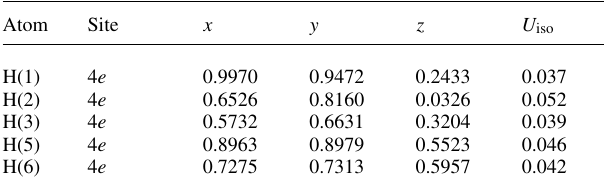
Table 2. Atomic coordinates and displacement parameters (in Å 2 )